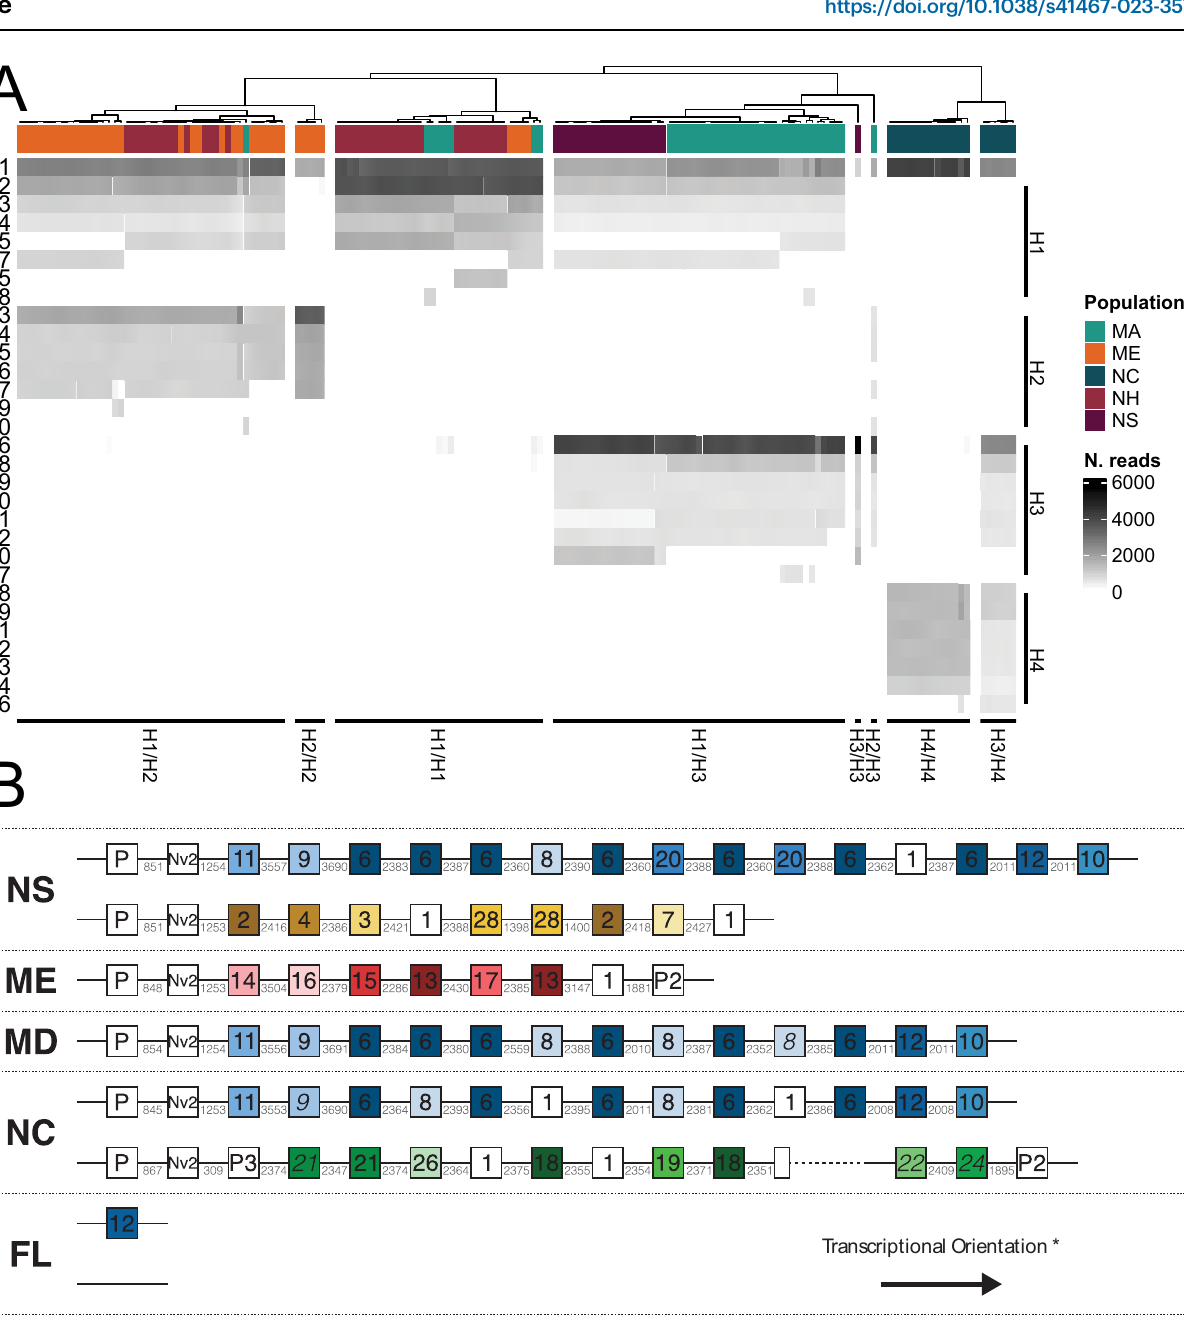
shared/undetermined)andcorrespondingmultiplesequencealignmentandamino acid variants are shown in Supplementary Figs. 3 and 4. Italicized variant labels correspond to the amplicon variant with the lowest pairwise distance to the genomic variant. Pseudogenes (P1, P2, and P3) and Nv2 copies are labeled sepa- rately. Intergenic distances are shown in gray and dashed line indicates a gap of unknown distance. *All loci are shown in the same transcriptional orientation and all variants within each locus share the same